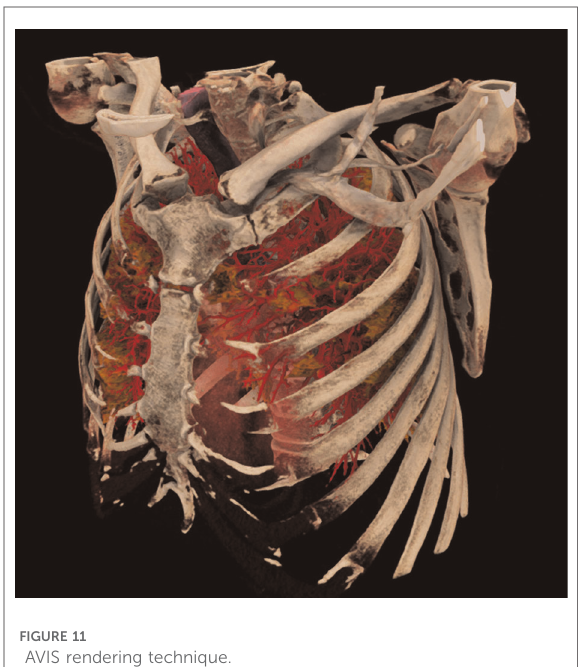
FIGURE 11 AVIS rendering technique.